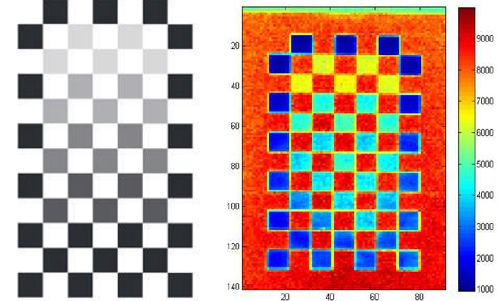
Figure 7. Checkerboard of grey levels (left) and corresponding intensity image (right)